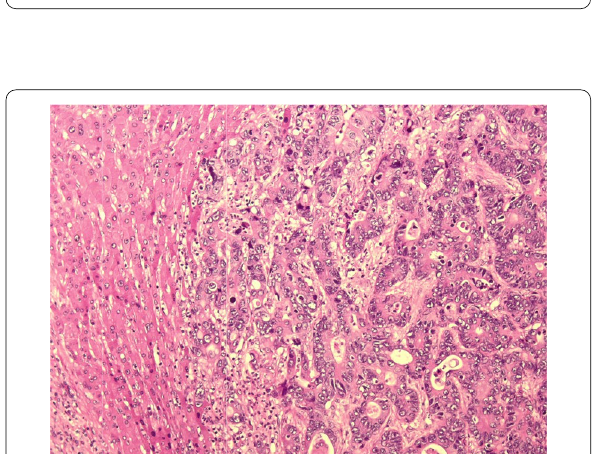
Fig. 4 Histological examination reveals tall columnar tumor cells forming small glandular duct structures. The pathological diagnosis is moderately differentiated tubular adenocarcinoma (hematoxylin and eosin staining, 10) ×